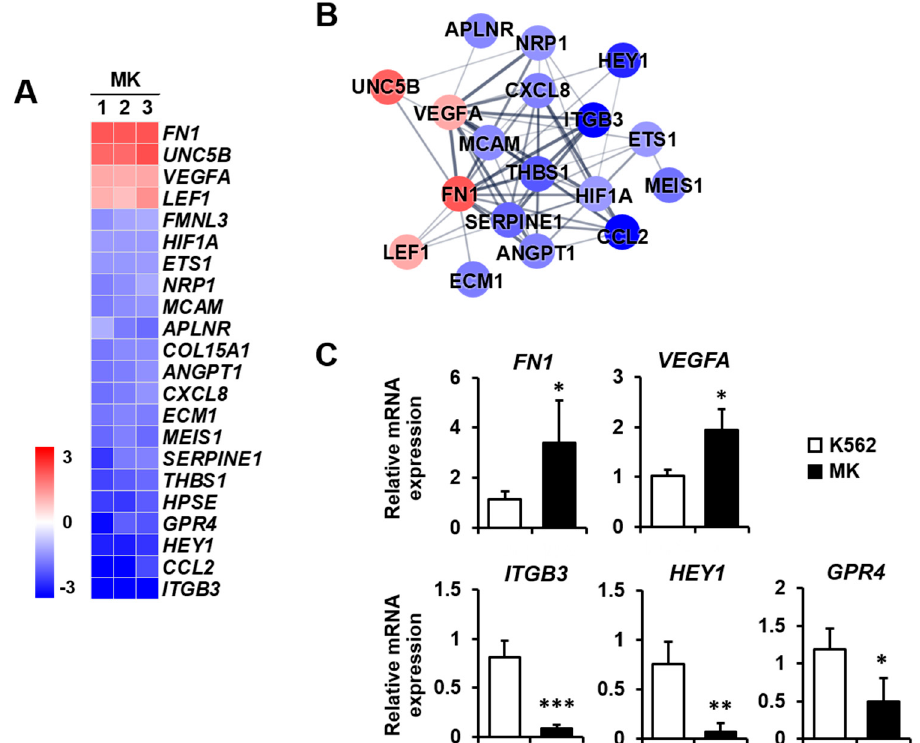
Figure 4. Expression levels by z-scores of genes included in the angiogenesis cluster and the relationship between constituent genes. ( A ) Heat map of genes differentially expressed in MK compared with K562 cells based on the microarray analysis. The red color indicates upregulation and the blue color indicates downregulation. The degrees of colors represent the expression levels of the genes. ( B ) Protein–protein interaction analysis using the STRING database. The red and blue colors denote upregulation and downregulation, respectively. The higher the confidence in the interaction, the greater the line thickness between the proteins. Members without interaction with other genes were excluded from the STRING database analysis. ( C ) Validation of the mRNA expression of selected genes ( FN1, VEGFA, ITGB3, HEY1, and GPR4 ) differentially expressed in MK by qPCR. Relative expression levels were plotted against gene expression levels in K562 cells. Data are presented as the mean ± standard deviation of three independent experiments. Please see abbreviations for the full names of genes. *, p < 0.05; **, p < 0.01; ***, p < 0.001 versus K562 cells.